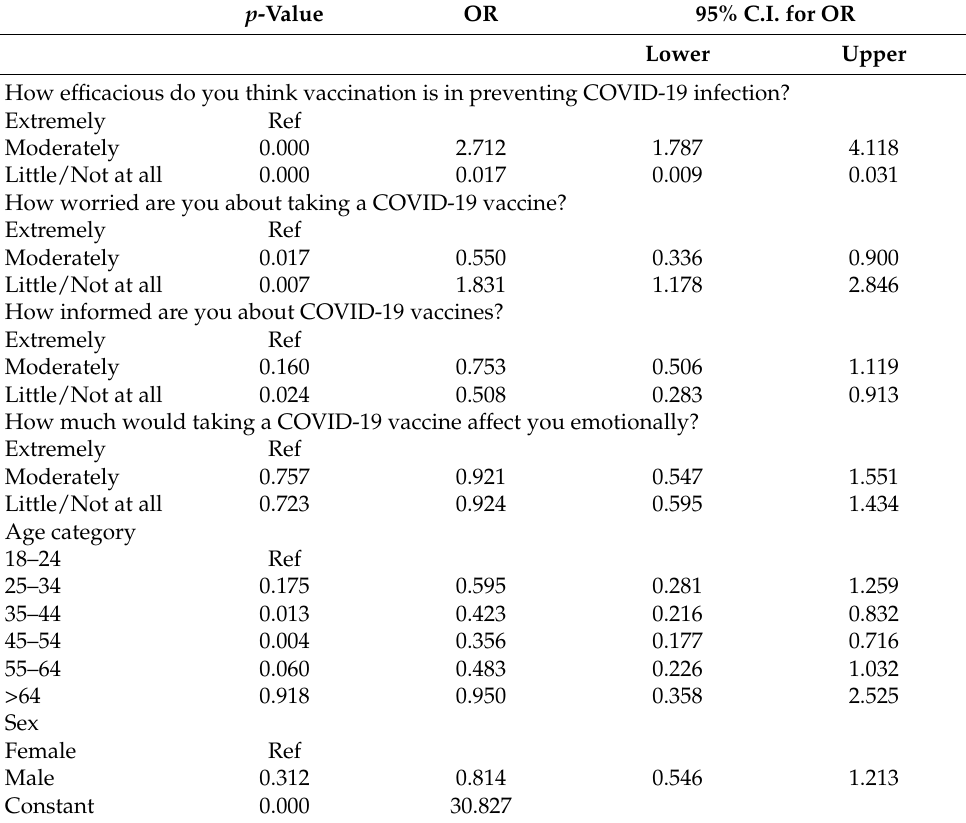
Table 3. Perceived vaccine effectiveness and vaccine